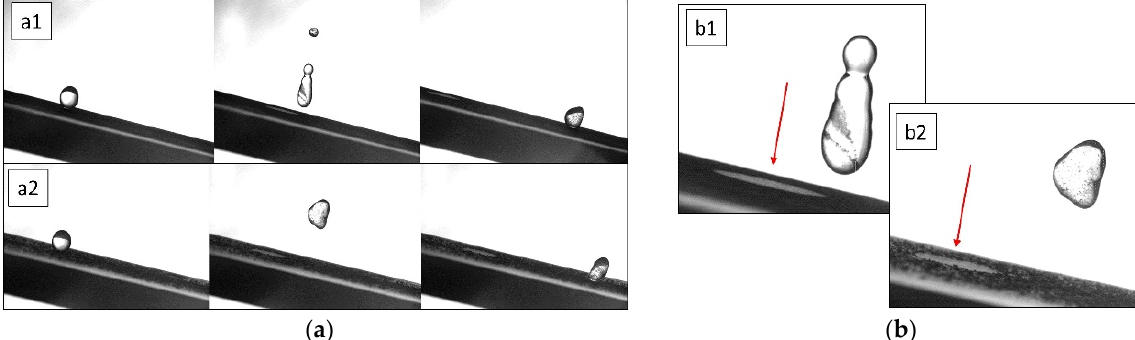
Figure 5. Snapshot acquired by the high-speed camera at 3500 fps (Sprinter HD, Optronis). ( a ) Drop impact on SHS tilted surface covered by CB (a1) and Al 2 O 3 powders (a2), ( b ) detail from the second frame of a1 and a2 in which is possible to observe (red arrow) the dust’s removal by the water droplet after impact on SH sample covered with CB (b1) and Al 2 O 3 powder (b2). Collected dust particles are visible in the droplet volume.